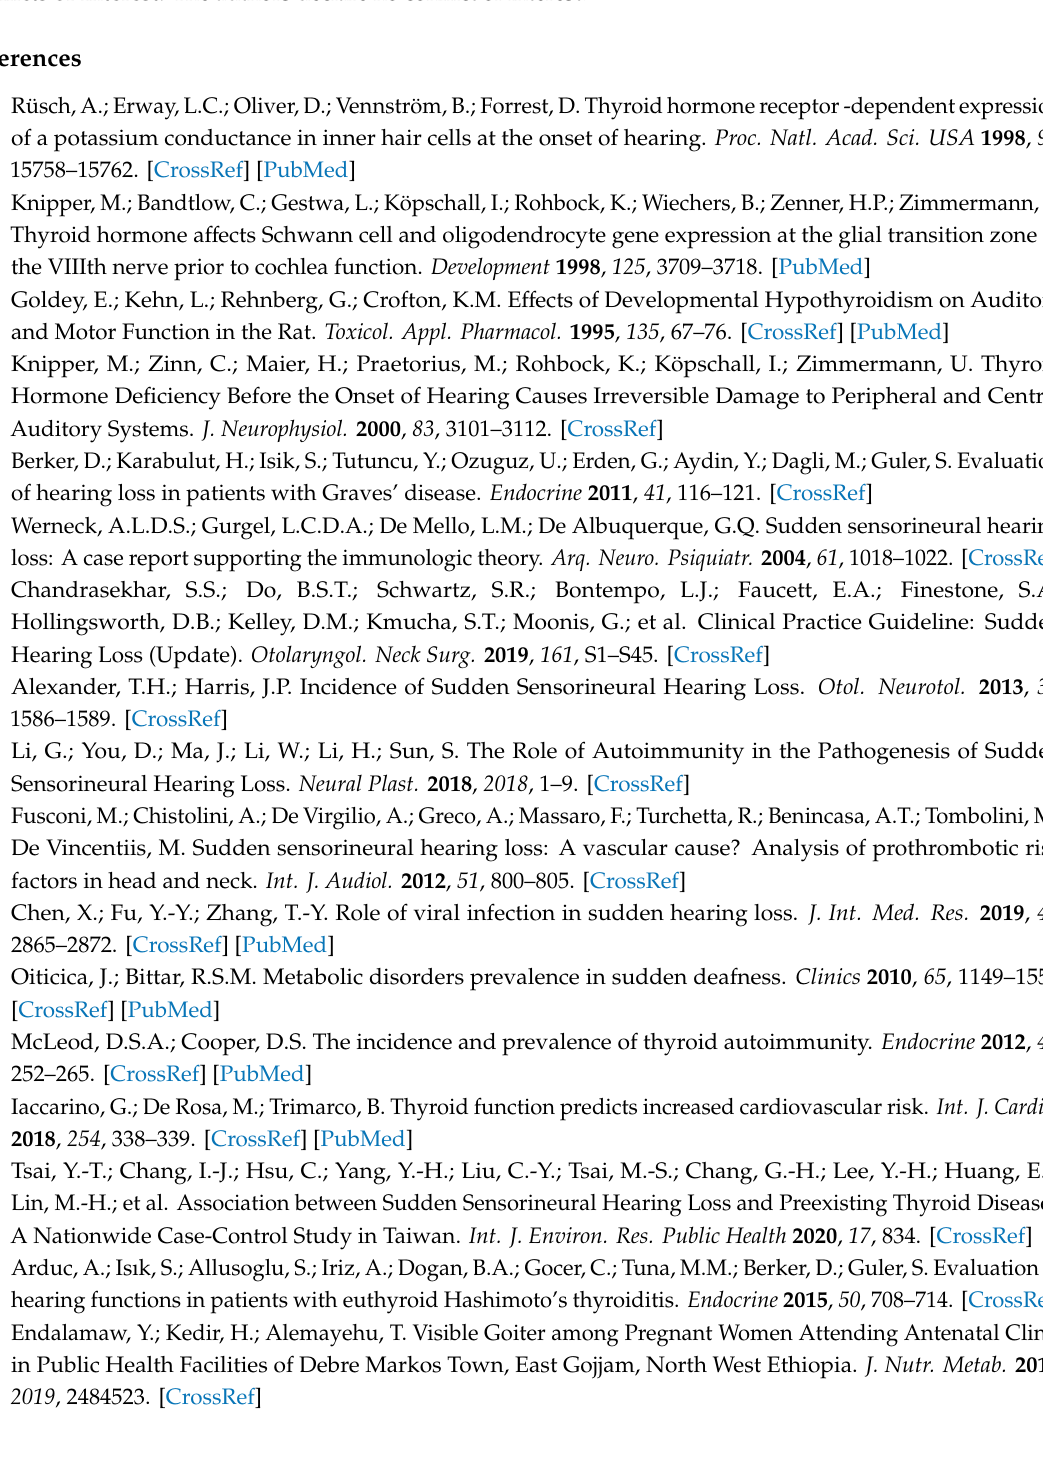
hyperthyroidism, Table S2: Subgroup analyses of crude and adjusted odd ratios (95% confidence interval) for SSNHL in synthroid, goiter, hypothyroidism, thyroiditis, and hyperthyroidism according to age and sex, Table S3: Subgroup analyses of crude and adjusted odd ratios (95% confidence interval) for SSNHL in synthroid, goiter, hypothyroidism, thyroiditis, and hyperthyroidism according to income and